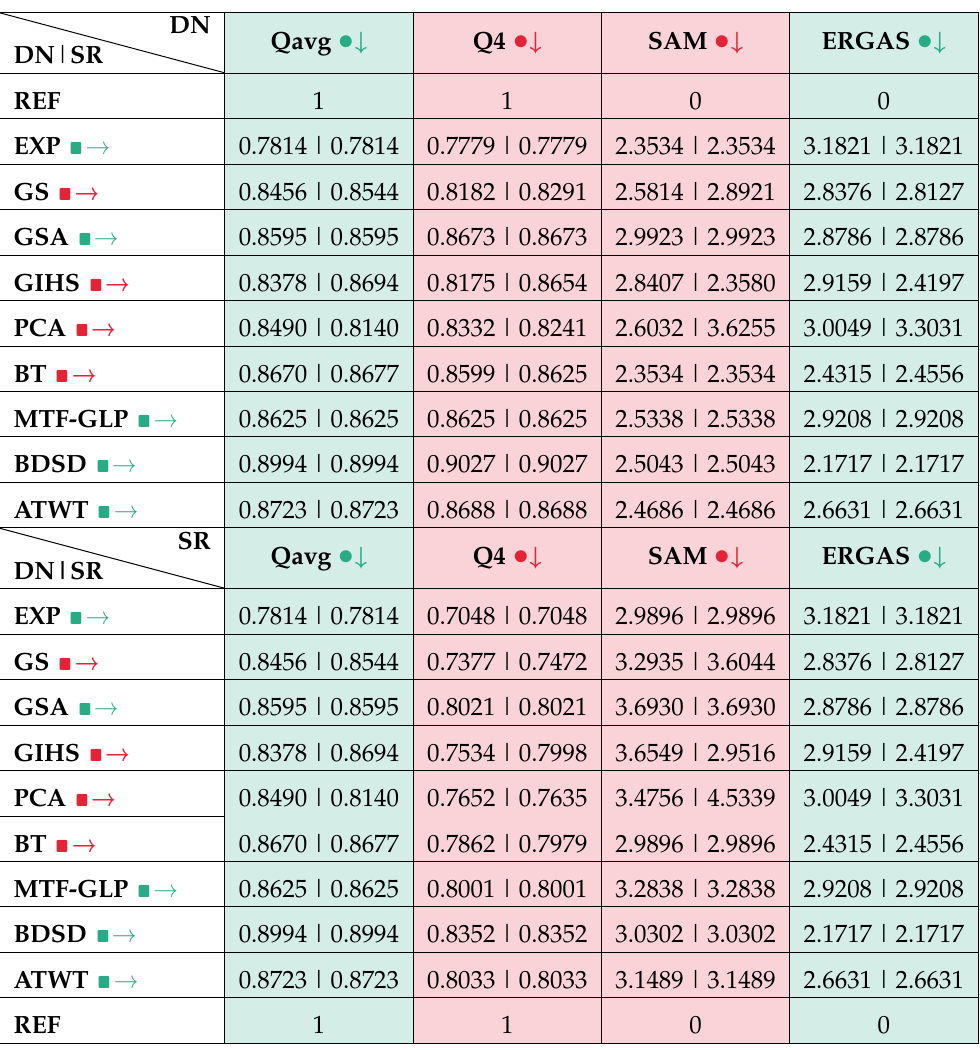
Table 5. Scores of GeoEye-1 Collazzone towards ground truth (REF) for nine fusion methods described in [39]. The upper subtable refers to assessments carried out on data in DN; the lower one in SR. Each entry of the table contains the values of a quality/distortion index relativ to fusion performed in either DN or SR. Reproducible indexes are highlighted in green; non-reproducible in red. Reproducible methods are marked by green squares; non-reproducible by red